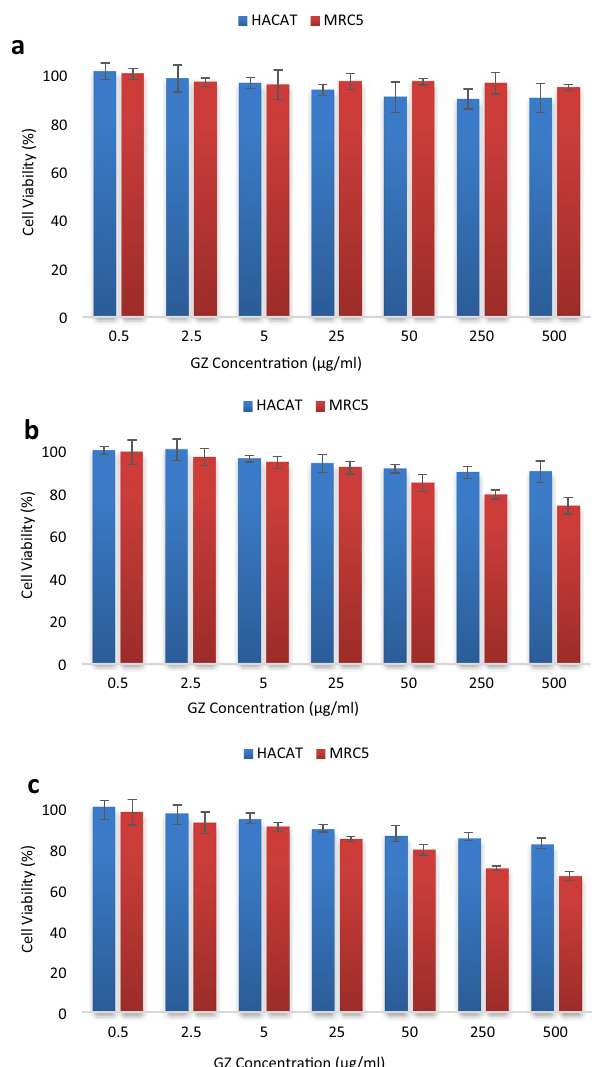
Figure 4. Cell viability of HaCaT and MRC5 cells lines treated with GZ nanocomposite for ( a ) 24 h, ( b ) 48 h, ( c ) 72 h. HaCaT and MRC5 cell lines were generally healthy after incubation with GZ nanocomposite. GZ nanocomposite was considered to be biocompatible for both cell